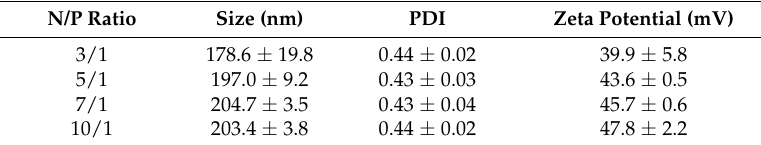
Table 1. Physicochemical properties of DDNPs prepared by different N/P ratios ( n = 3).